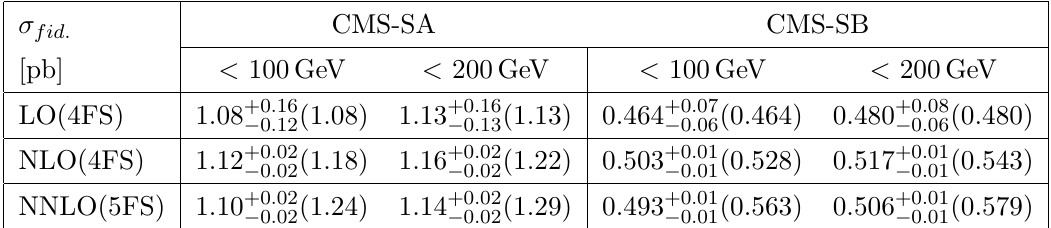
Table 5 . Fiducial cross section at various orders in QCD for LHC 13 TeV, comparing 4FS with 5FS. Scale variations are evaluated by taking the envelop of results with 9 scale choices. Numbers in parenthesis correspond to predictions without including QCD corrections in decay of top